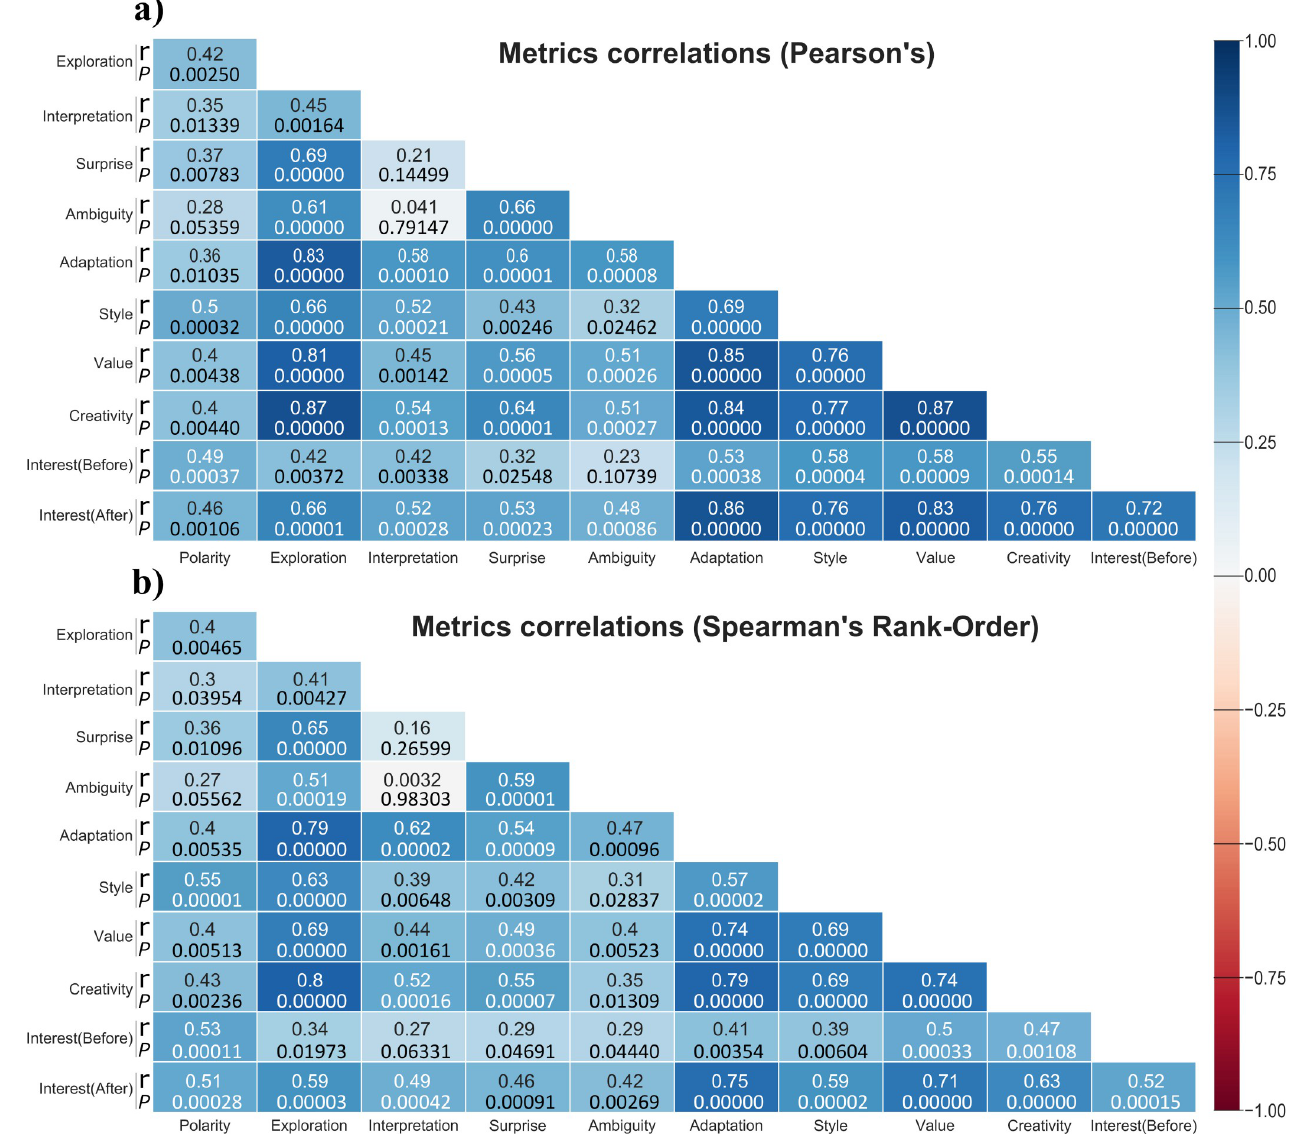
Fig 24. Correlations (r) and their P -values ( P ) comparing all distributions of perception scores and